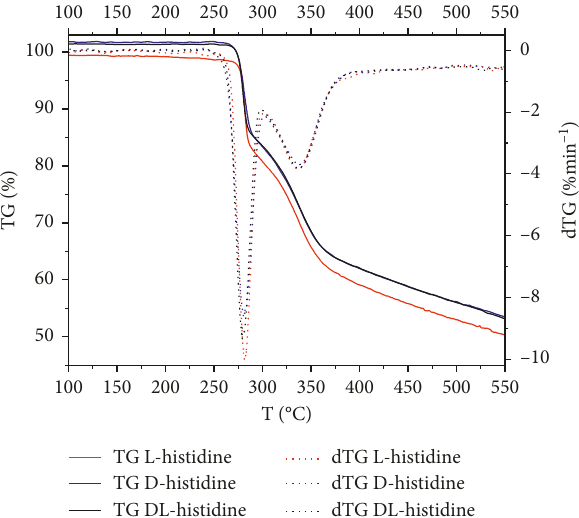
Figure 2: TG-DTG curves for L-, D-, and Table 4: Thermogravimetric data of isomeric histidines (10 ° C min − 1 ). Isomers histidines